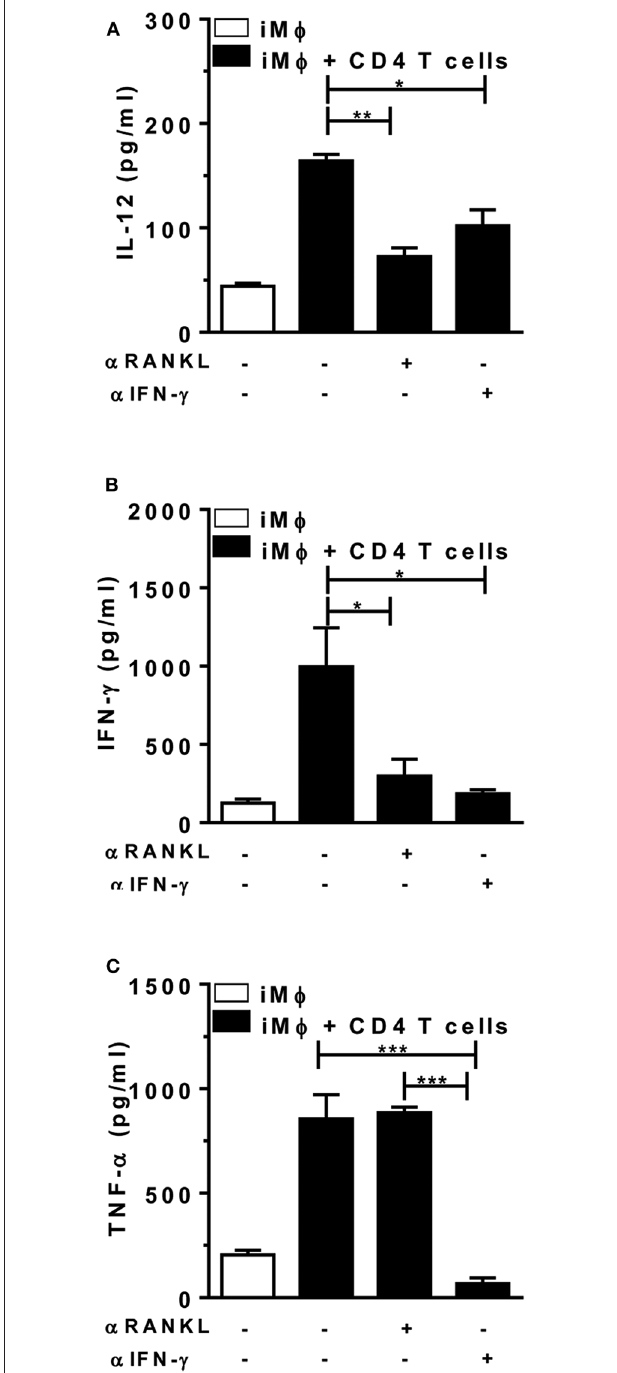
FIGURE 6 | Endogenous RANKL is involved in CD4 T-cell help to macrophages. Peritoneal (B6) macrophages (from mice injected i.p. with L. major ) were infected in vitro and then cultured alone or with CD4T cells from L. major -infected mice (at 5w.p.i.). Cultures were treated or not with anti-RANKL or anti-IFN- γ -neutralizing antibodies. (A-C) After 48h, culture supernatants were collected and assayed for (A) IL-12p70, (B) IFN- γ , and (C) TNF- α by ELISA. Results are expressed as means and S.E.M. Results from cocultures were analyzed by one-way ANOVA, followed by Tukey post-test. Significant differences were indicated for * P < 0.05, ** P < 0.01, *** P <